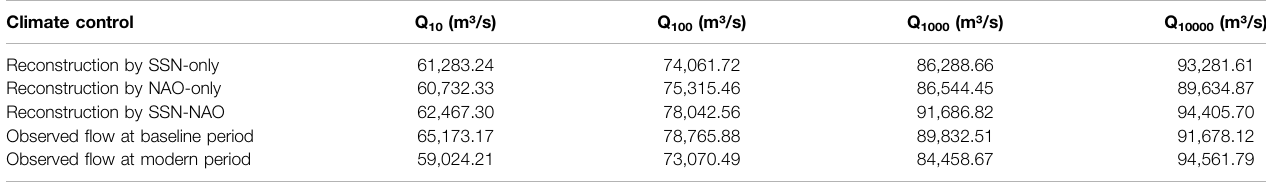
TABLE 9 | Observed and reconstructed fl ood magnitudes with different recurrence intervals by the BP model after the construction of the TGD (1994 – 2020). Climate control Reconstruction by SSN-only